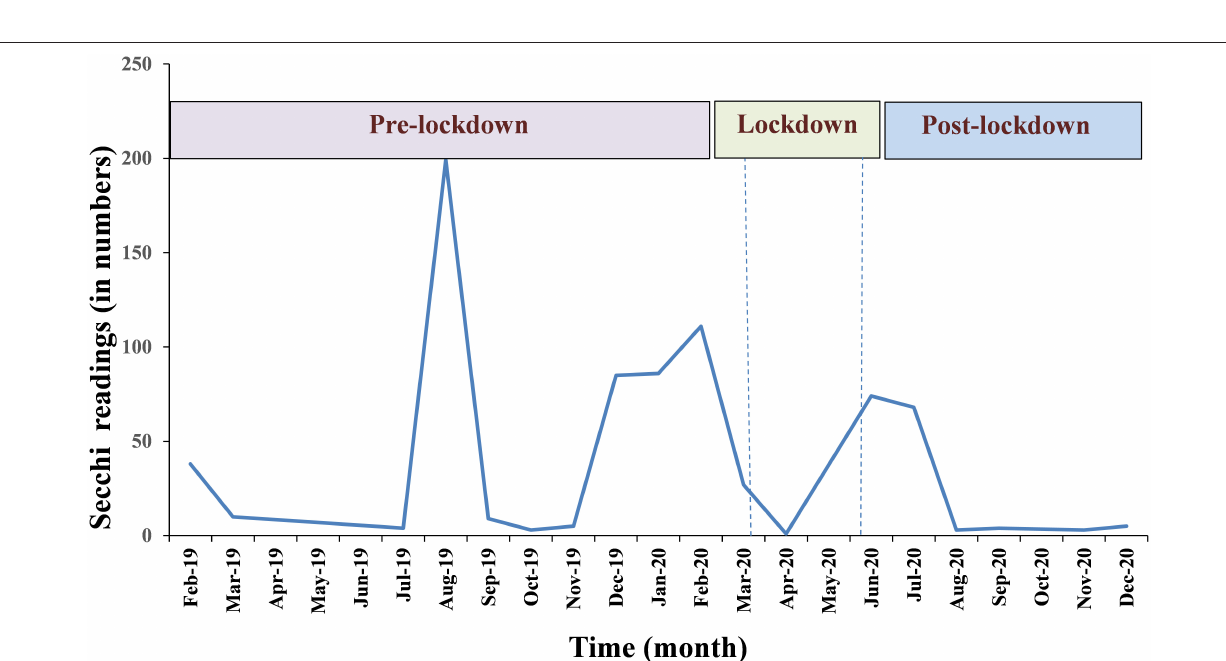
Frontiers in Water |